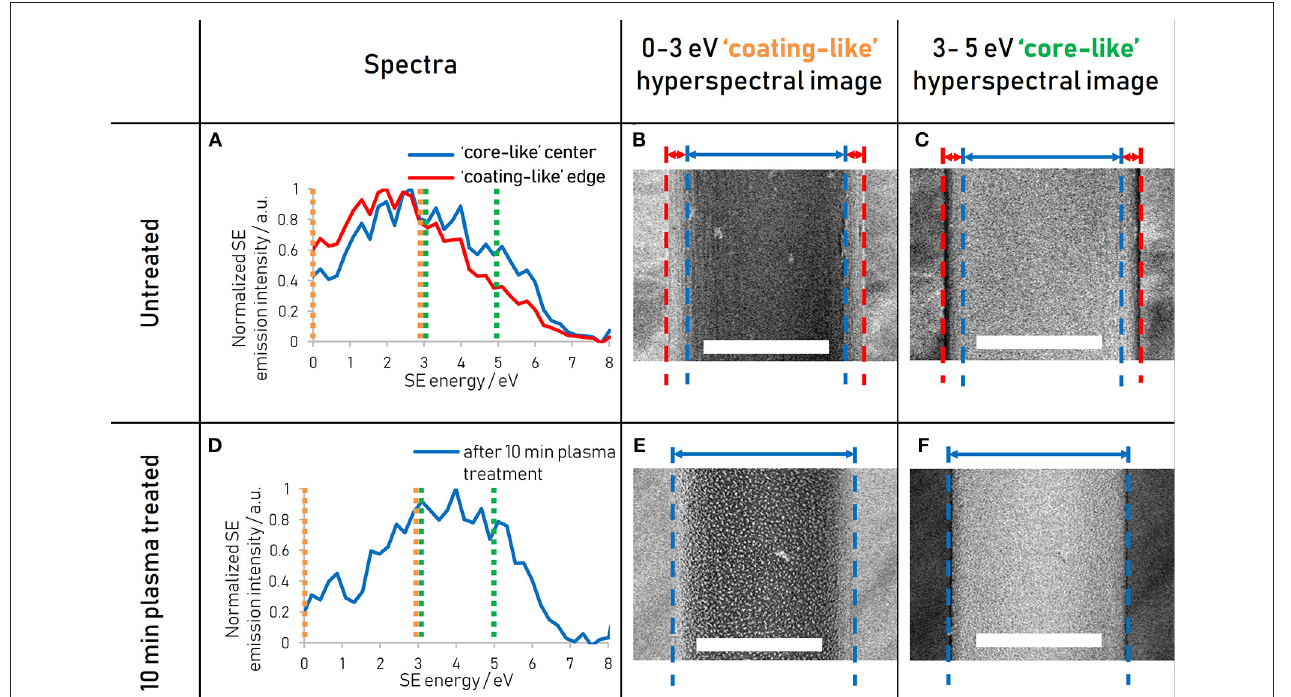
FIGURE 3 | (A) Spectra of untreated Nephila inaurata dragline silk highlighting differences between the coating-like spectrum arising from the edge (red lines) and the core-like spectrum arising form the middle (blue lines). (B) Hyperspectral image of the untreated fiber representing the energy range of 0–3eV highlighting the coating-like emissions and (C) 3–5eV energy range hyperspectral image highlighting the core-like emissions. (D) Spectrum of Nephila inaurata dragline silk after the removal of the coating and skin via a 10min plasma etch. (E) and (F) as (B) and (C) for the 10min treated sample. The hyperspectral energy ranges of 0–3 and 3–5eV are represented by orange and green dashed lines in the spectra of (A,D) , respectively. All spectral images acquired with 500eV primary beam energy. Scalebars measure 3 µ m.